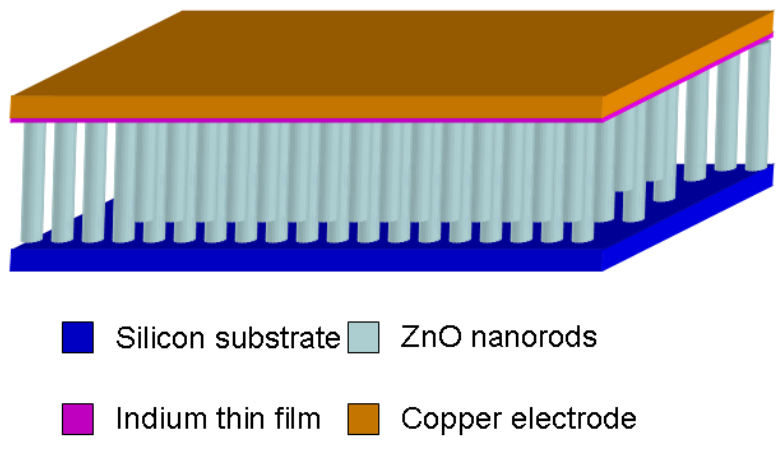
Figure 4. Schematic diagram illustrating the fabrication processes of the ZnO